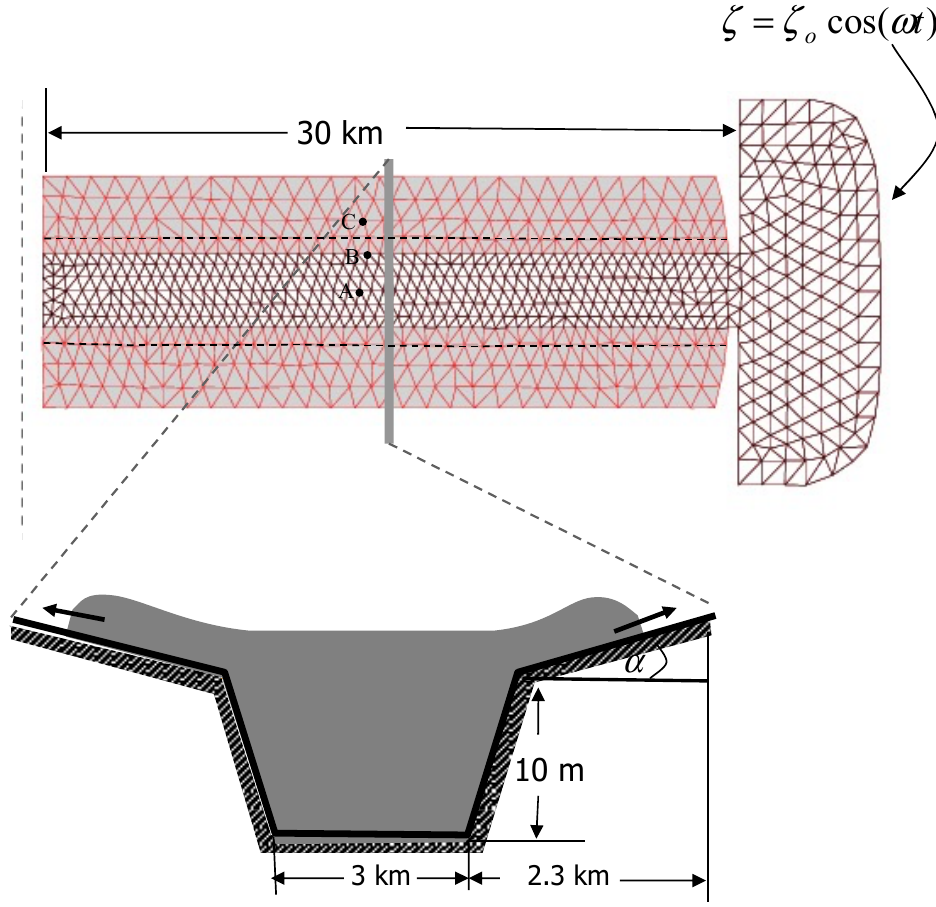
Figure 4. Unstructured triangular grid for the standard run plus a schematic view of the cross-channel section. The dashed line along the channel indicates the edge of the channel connected to the inter-tidal zone. Labels A, B, and C are the locations where the surface elevation ( ζ ), along-channel current (U), and cross-channel current (V) are